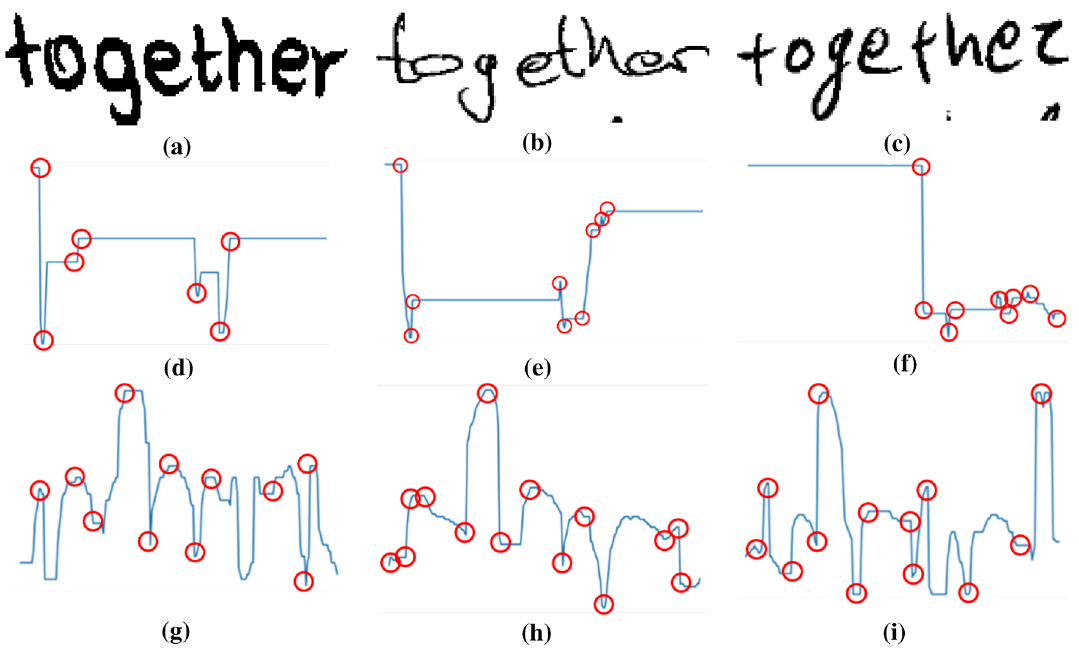
Fig. 9 The differences in upper profile ( d – f ) and lower profile ( g – i ) of three writing samples ( a – c ) of a particular word due to adaptive writing styles. Red-colored circles show some of the cusp points (i.e., points of non-differentiability) on the